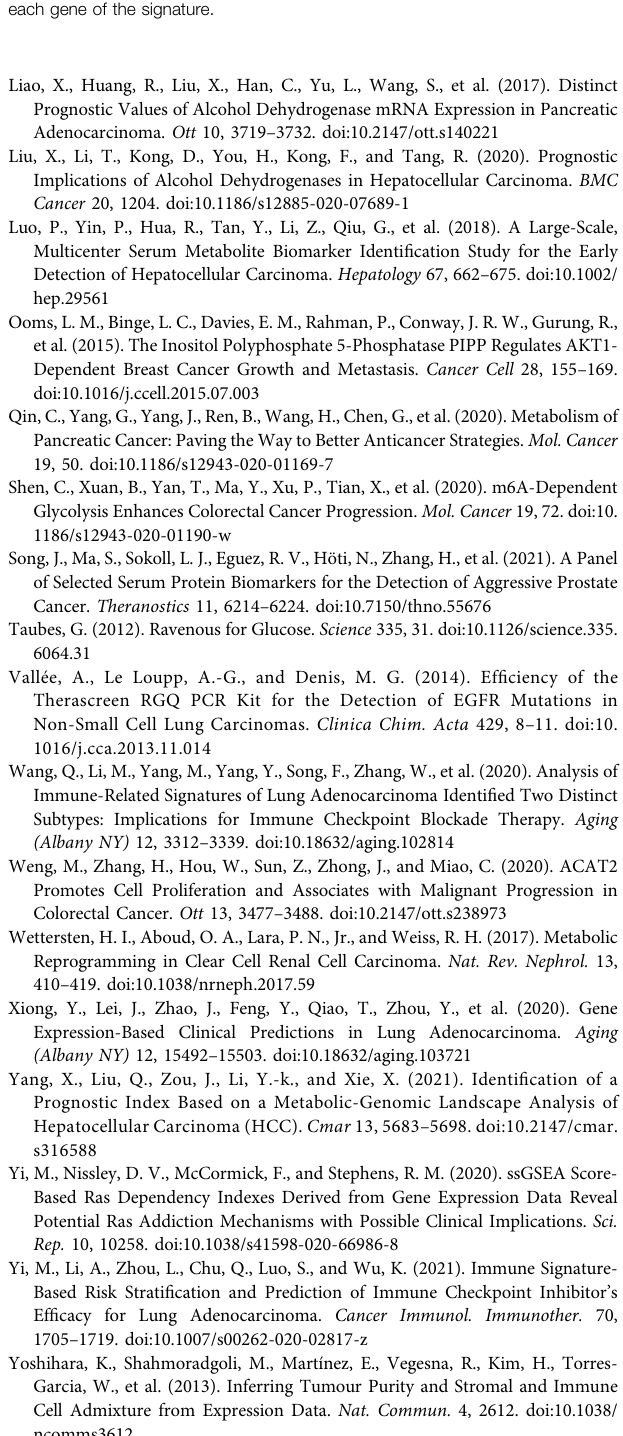
Supplementary Figure 2 | Correlation between the enrichment score of each pathway and the LUAD patients with N stage. Supplementary Figure 3 | Correlation between the enrichment score of each pathway and the LUAD patients with T stage. Supplementary Figure 4 | Correlation between the enrichment score of each pathway and the LUAD patients with M stage.